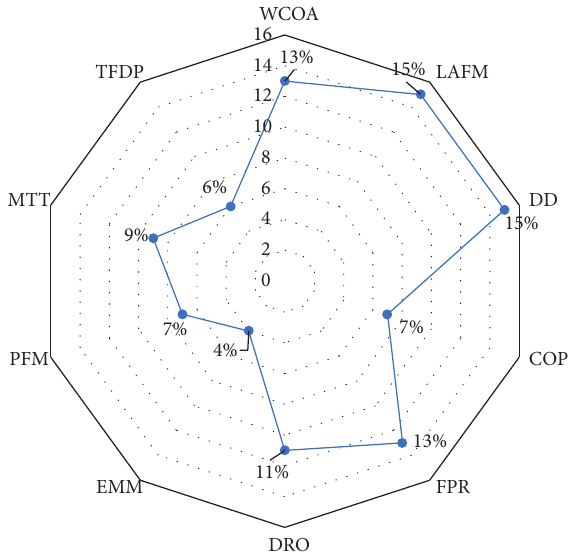
Figure 12: Percentage convergence of technologies in